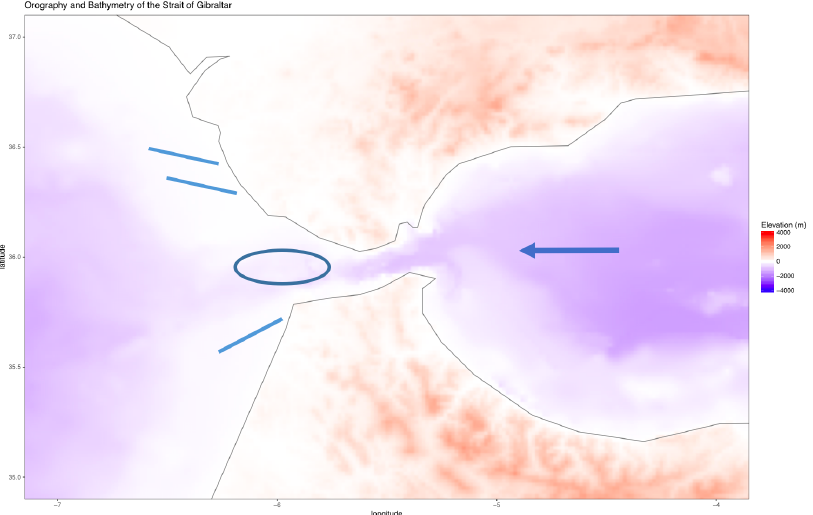
Figure 3. Orography and bathymetry [11] of the Strait of Gibraltar (m). The arrow indicates the Levanter wind. The oval shape marks the area of highest wind speeds during Levanter events and the light blue lines show areas of high wind speeds found by